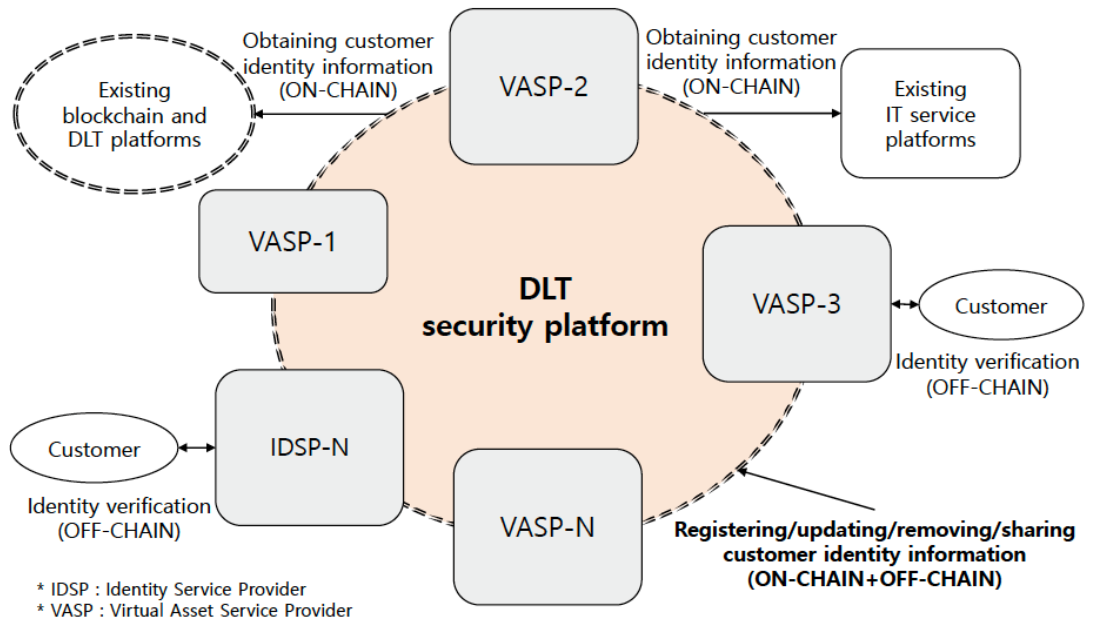
Figure 4. A diagram of customer identification service model based on DLT security platform.